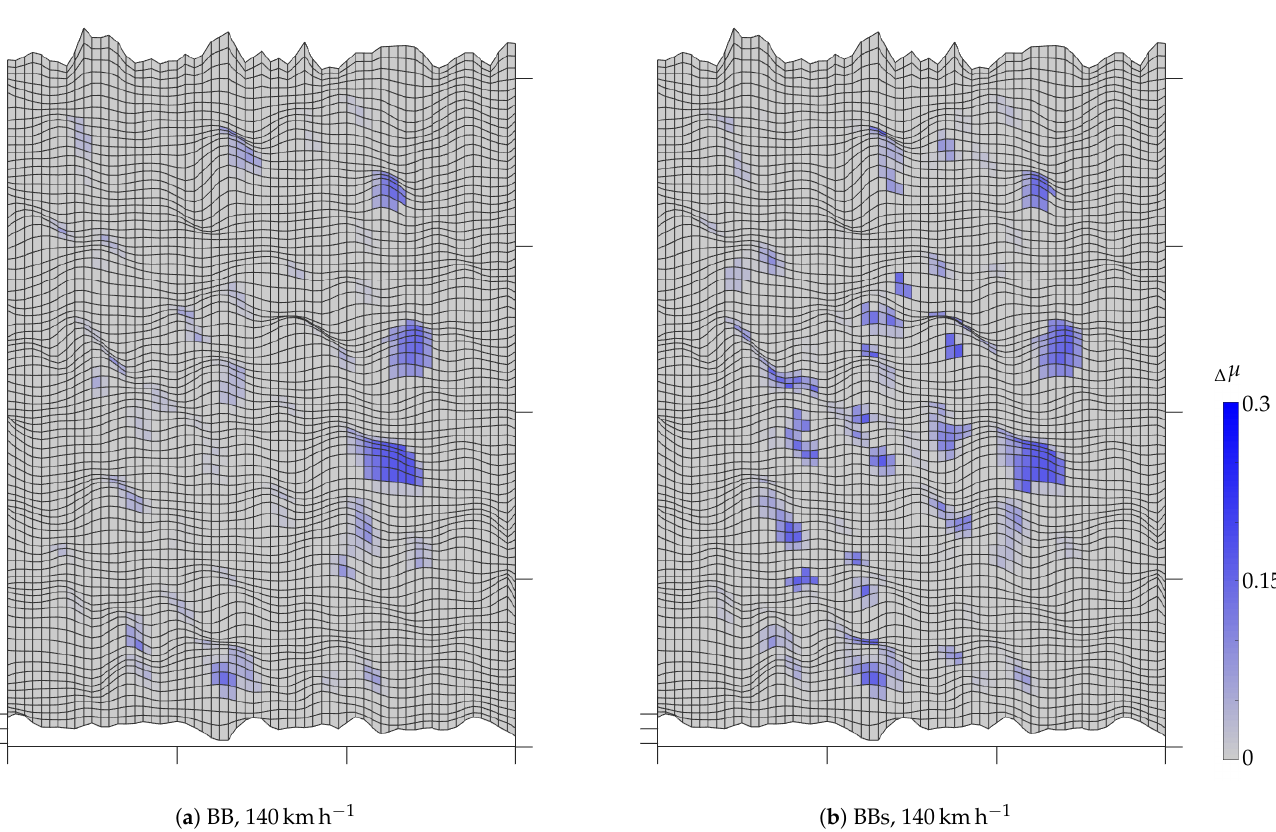
Figure 15. Change of the coefficient of friction ∆ µ due to the wiping edge effect. A 60mm × 80mm large section of the roadway is shown. Direction of travel is from left to